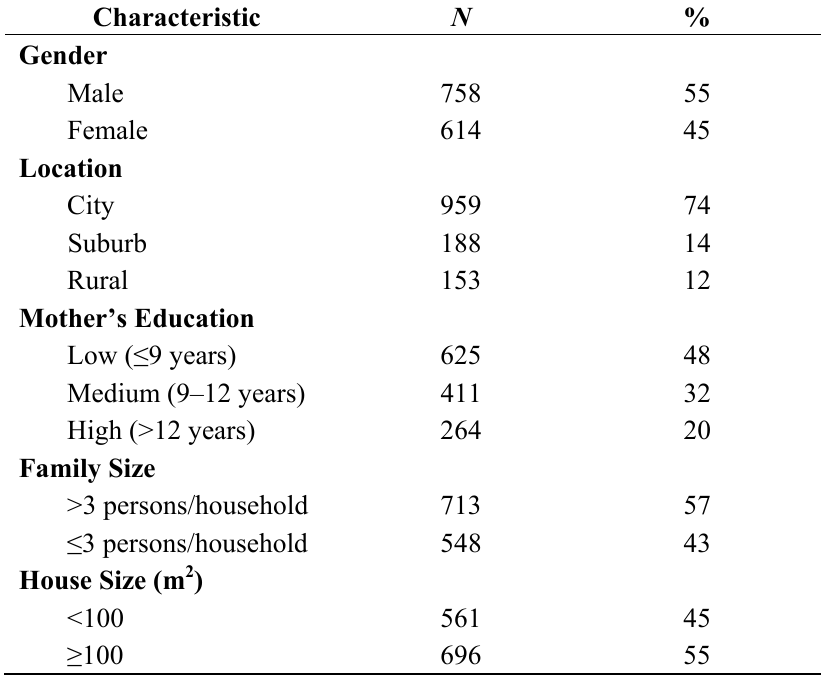
Table 1. Baseline characteristics of study population ( N =